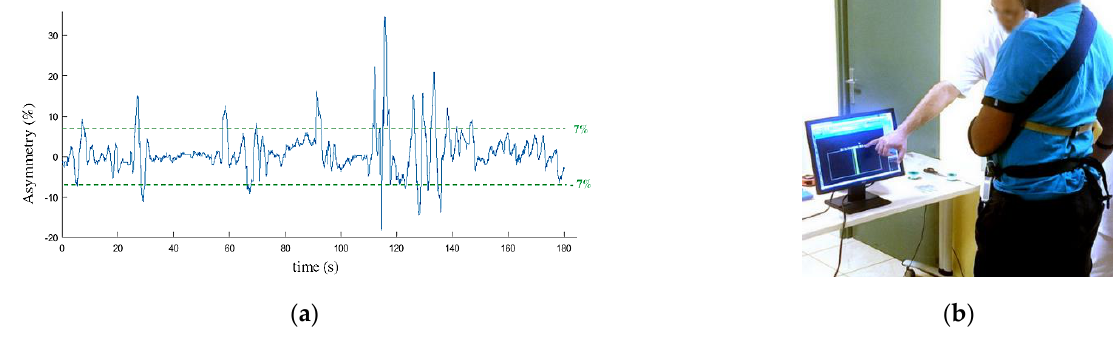
Figure 6. Balance training exercise: each participant was asked to maintain his balance to an asymmetry below 7% ( a ) of the total weight during 180 s with the help of a visual feedback ( b ).